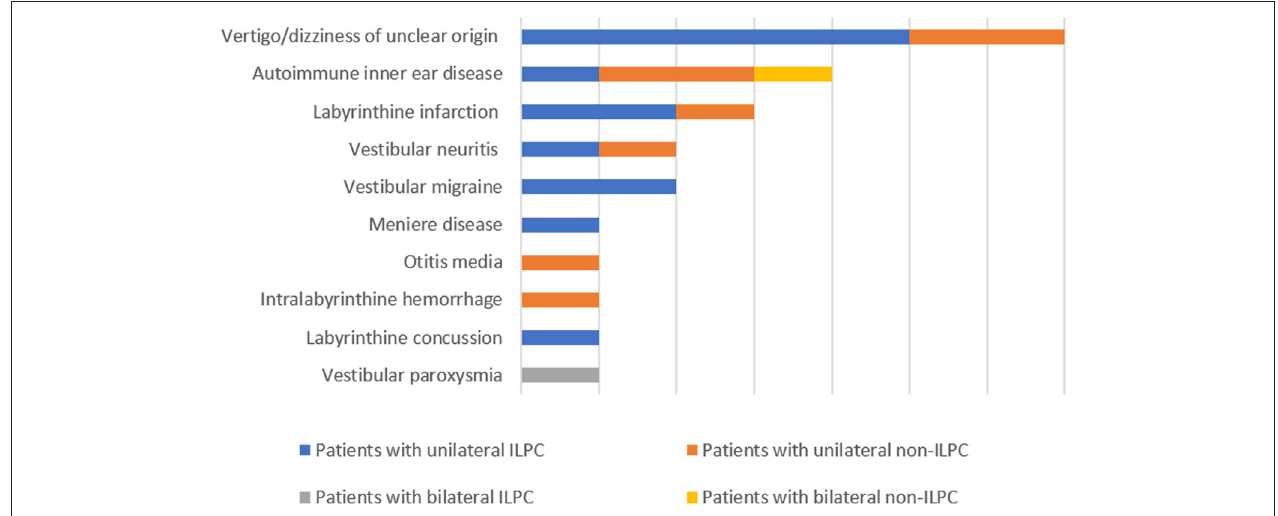
FIGURE 1 | Different diagnosis in patients with the loss of the posterior canal (s)